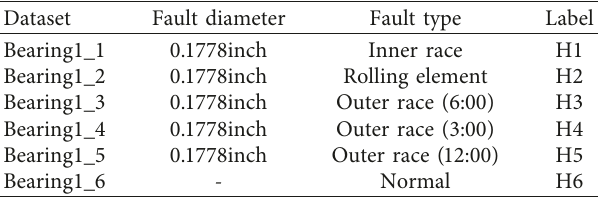
Table 1: Data introduction (CWRU bearing datasets).